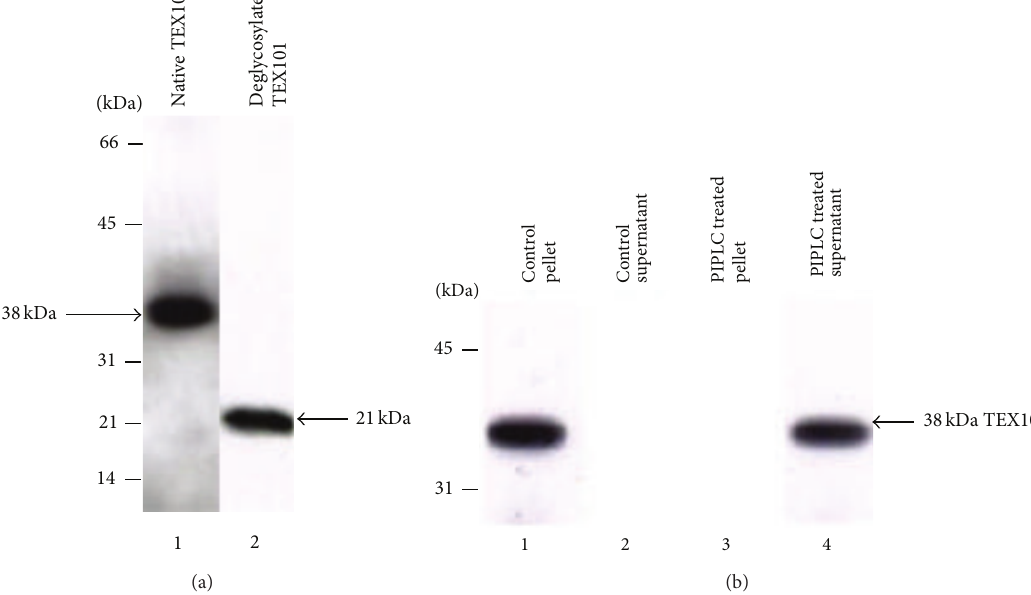
Figure 7: (a) Immunoblots of cauda sperm plasma membrane fraction treated with N-glycanase analyzed by reducing SDS-PAGE on 15% gels and immunostained with anti-TEX101. Lane 1 represents the untreated TEX101 polypeptide, and lane 2 displays N-glycanase treated TEX101 polypeptide. Note the reduction in molecular weight ( ∼ 17kDa) of the deglycosylated sample. Each lane contains 15 𝜇 g protein. (b) Western blot analysis of TEX101 polypeptide treated with PIPLC and immunostained with anti-TEX101. Lanes 1 and 2 display the untreated plasma membranes (control) of pellet and supernatant fractions, respectively. TEX101 is present in the pellet fraction (lane 1). Lanes 3 and 4 exhibit the pellet and the supernatant fractions of PIPLC treated plasma membranes, respectively. Note that there is a complete release of TEX101 polypeptide in the supernatant fraction (lane 4) of PIPLC treated plasma membranes. The amount of plasma membrane proteins employed in the control and PIPLC treated experiments was 15 𝜇